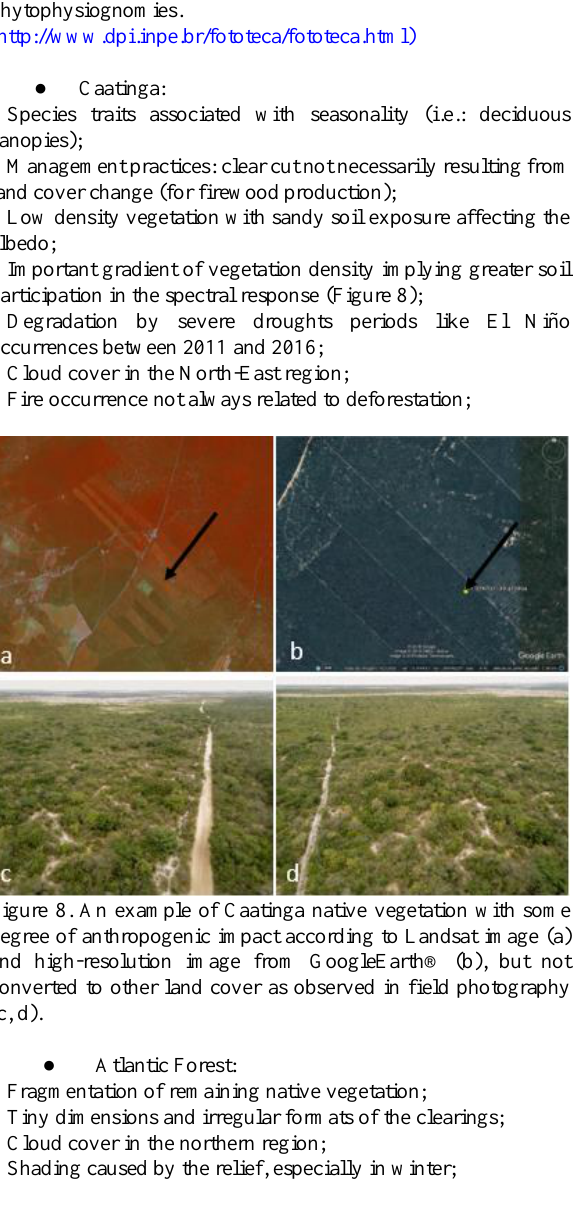
Figure 7. An example of Cerrado vegetation observation: field photography and high resolution image from GoogleEarth.